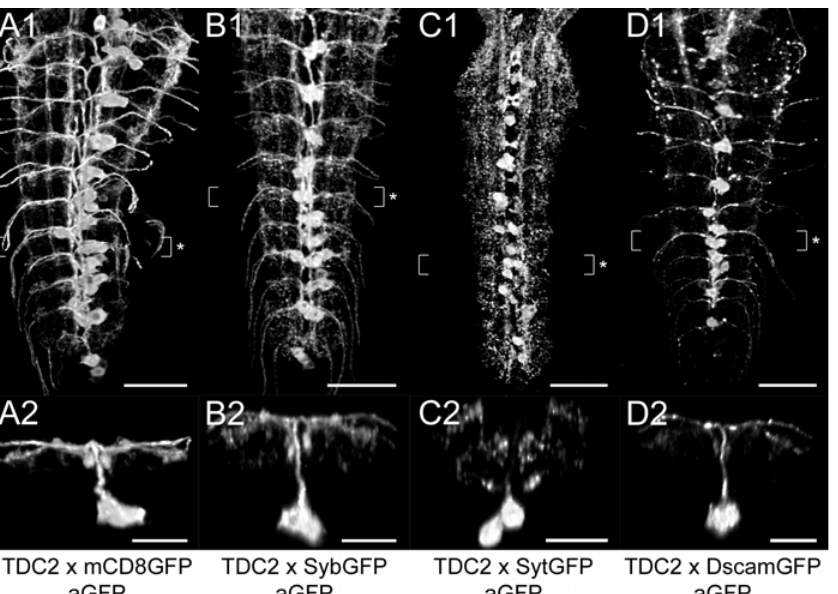
Figure 9. Distribution of ectopically expressed neuronal compartment markers in TDC2 neurons. (A1-D1) Dorsal view of GFP immunoreactivity in the VG of larvae expressing Tdc2-gal4- driven mCD8GFP (A1-2), SybGFP (B1-2), SytGFP (C1-2), or DscamGFP (D1-2). (A2-D2) Corresponding transversal views of the neuromeres a3 or a4 (* in A1-D1). All images are auto-contrasted maximum pixel intensity projections of volume-rendered 3D image stacks. Scale bars: 50 m m in A1-D1), 25 m m in